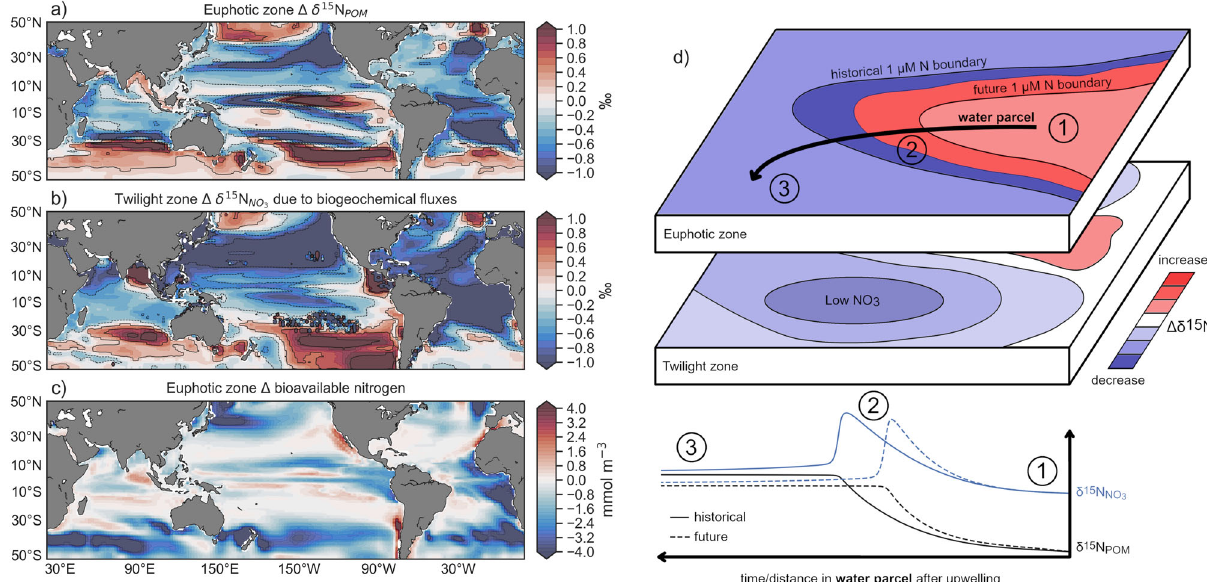
Fig. 3 Biogeochemical control on the nitrogen cycle perturbation. a Climate change effect on euphotic zone δ 15 N POM . b Climate change effects on twilight zone δ 15 N NO3 due to biogeochemical processes only. c Change in euphotic zone bioavailable nitrogen (nitrate plus ammonium). d Schematic describing a major mechanism of δ 15 N depletion in our experiments. Less upwelled bioavailable nitrogen (N) within a water parcel travelling from an upwelling zone (1) to the subtropical gyres (3) leads to lower δ 15 N POM outside of the productive zone. Greater nitrogen limitation of phytoplankton generates less enrichment of 15 N in unused nitrogen (1), leading to a lower peak in δ 15 N NO3 and δ 15 N POM at the boundary between nitrogen-replete and nitrogen-limited regimes (2). conditions. This depleted signal is carried laterally into the nitrogen-limited gyres (3) and delivered to the twilight zone via remineralization of low δ 15 N POM